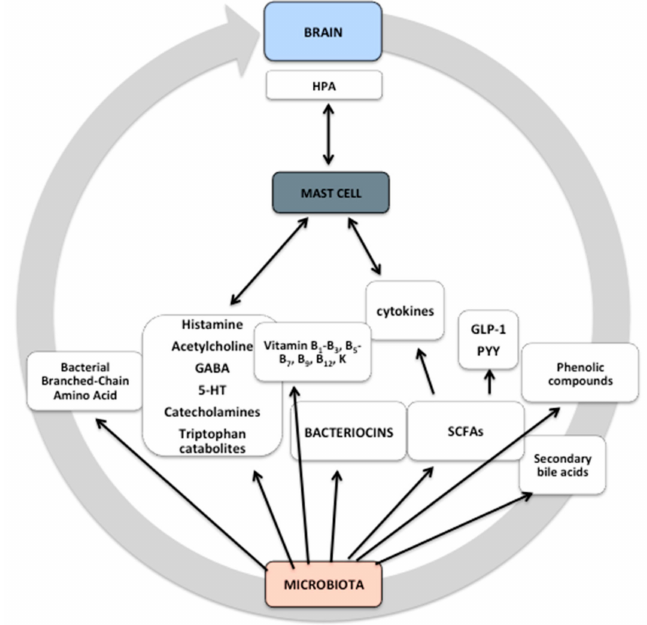
Figure 1. Microbiota-derived molecules. Microbiota-derived molecules are produced as intermediates or end products of microbial metabolism. These molecules can be derived directly from bacteria or from modification of other molecules, such as bile acids, and they influence fundamental biological functions. Some microbial products may pass through the blood–brain barrier (BBB), thereby a ff ecting it. The microbiota and its metabolites can control events both in the peripheral and the central nervous system (CNS) through nerve activation, cytokine production, neurotransmitters, and short-chain fatty acid (SCFA) release, as well as via systemic circulation. Some signals may activate mast cells that are both sensors and e ff ectors of cytokines and neuropeptides / neurotransmitters, a ff ecting hypothalamic–pituitary–adrenal (HPA) activity. The exact mechanism remains unknown. GABA, gamma-aminobutyric acid; 5-HT,